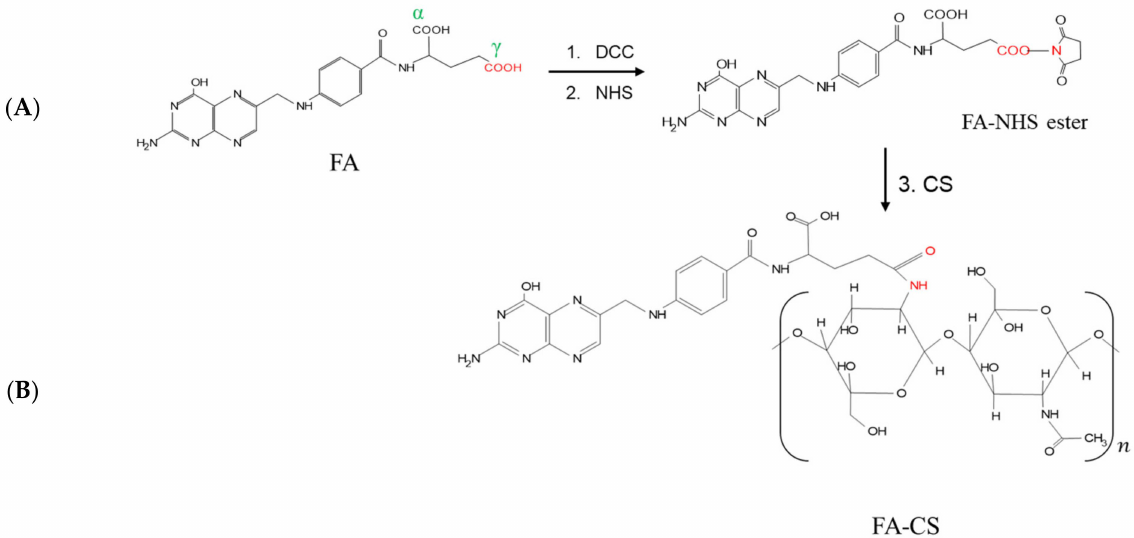
Figure 1. Reaction scheme for the synthesis of ( A ) FA-NHS-ester using DCC and NHS in DMSO, 24 h, room temperature; ( B ) FA-CS using the FA-NHS ester and CS solution, 24 h, room